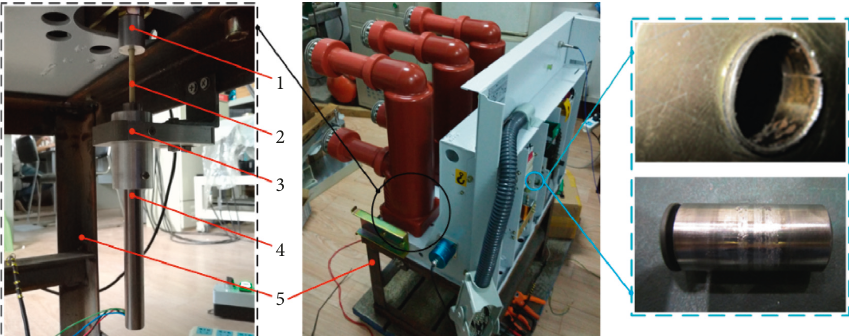
Figure 4: The operation experiment. 1: sleeve; 2: measuring probe; 3: auxiliary component; 4: sensor; and 5: